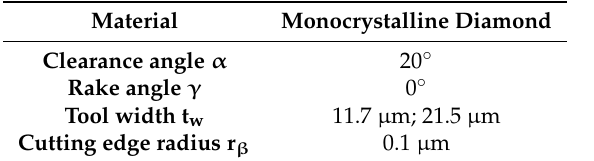
Table 1. Tool characteristics.